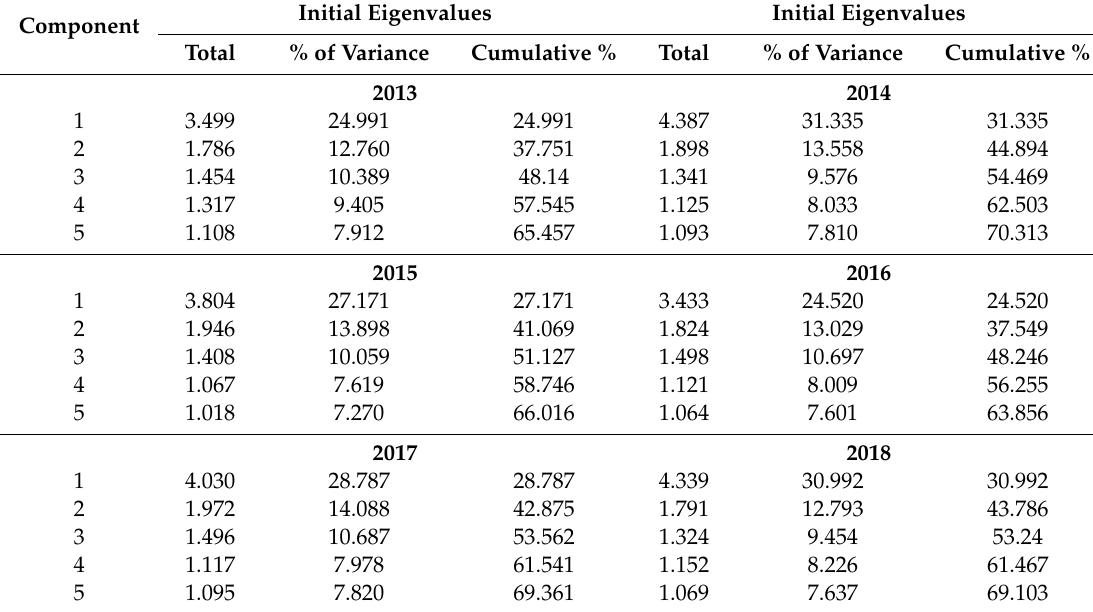
Table 2. Variance of five components explained for the data of maize seed quality indices from 2013 to